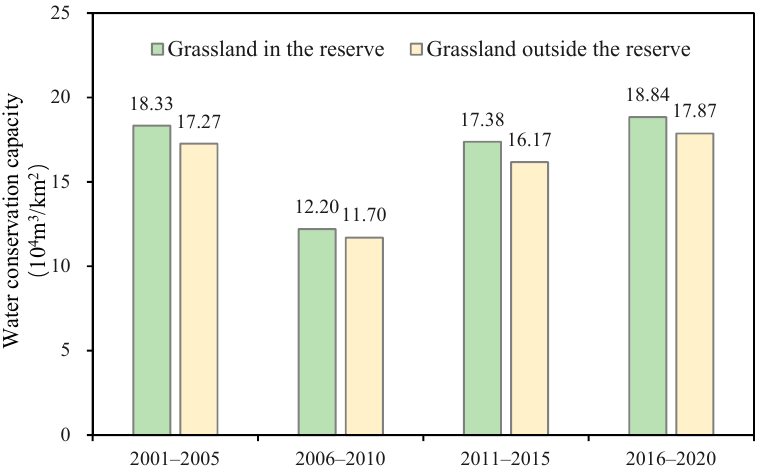
Figure 9. Annual change of water conservation in Zoige county from 2001 to 2020. From 2001 to 2020, water conservation in Zoige county increased at a rate of 0.25 × 10 4 m 3 /km 2 /year, and 84.55% of the region exhibited an increasing trend. Areas with the fastest growth rates were mainly located in the northern part of the reserve and the forested areas in the eastern part of Zoige county. Overall, water conservation in 15.02% of the county decreased, and the areas with the fastest decrease were mainly distributed in the west and south of Zoige county (Figure